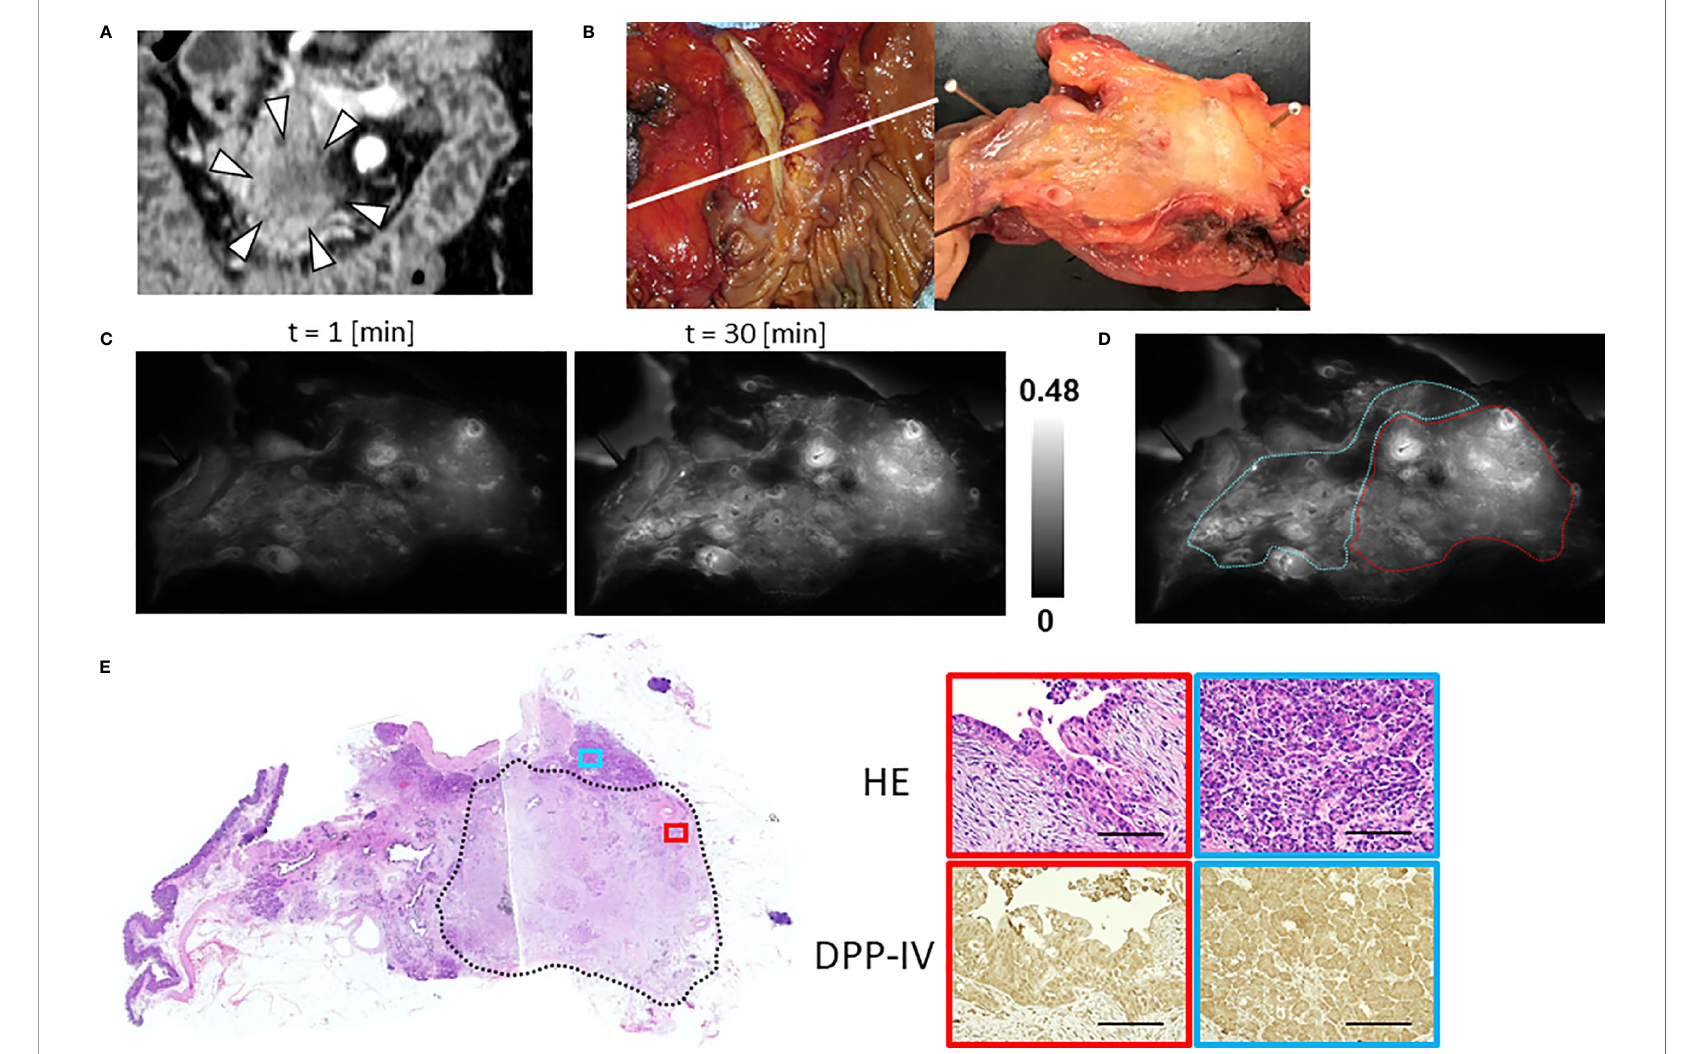
FIGURE 3 | Fluorescence imaging using GP-HMRG to probe whole surgical specimens demonstrates heterogenous increases in fl uorescence signals emitted by pancreatic cancer tissues (Patient No. 6). (A) Preoperative contrast-enhanced computed tomography of pancreatic head cancer (arrowheads). (B) Macroscopic image of the PD specimen (left) and cut surface along the white line including the tumor (right). (C) Increase of fl uorescence signals after spraying GP-HMRG on the cut surface. (D) Relationships between fl uorescence signals and distributions of cancer tissues (red dotted line) and surrounding pancreatic tissues (blue dotted line) according to histological fi ndings. (E) Low-magni fi cation histopathological image of H&E staining corresponding to fl uorescence images (left, dotted line indicates cancer boundaries). Magni fi ed views of H&E staining and IHC analysis of DPP-IV in cancer (red) and pancreatic (blue) tissues (right). Scale bar = 100